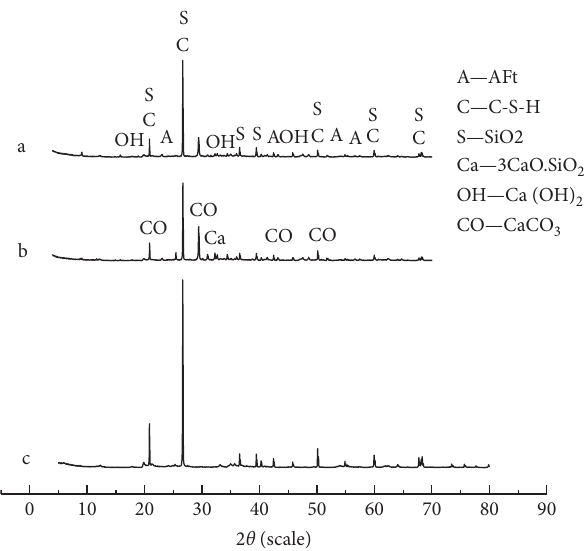
Figure 12: XRD diagram of different curing ages.